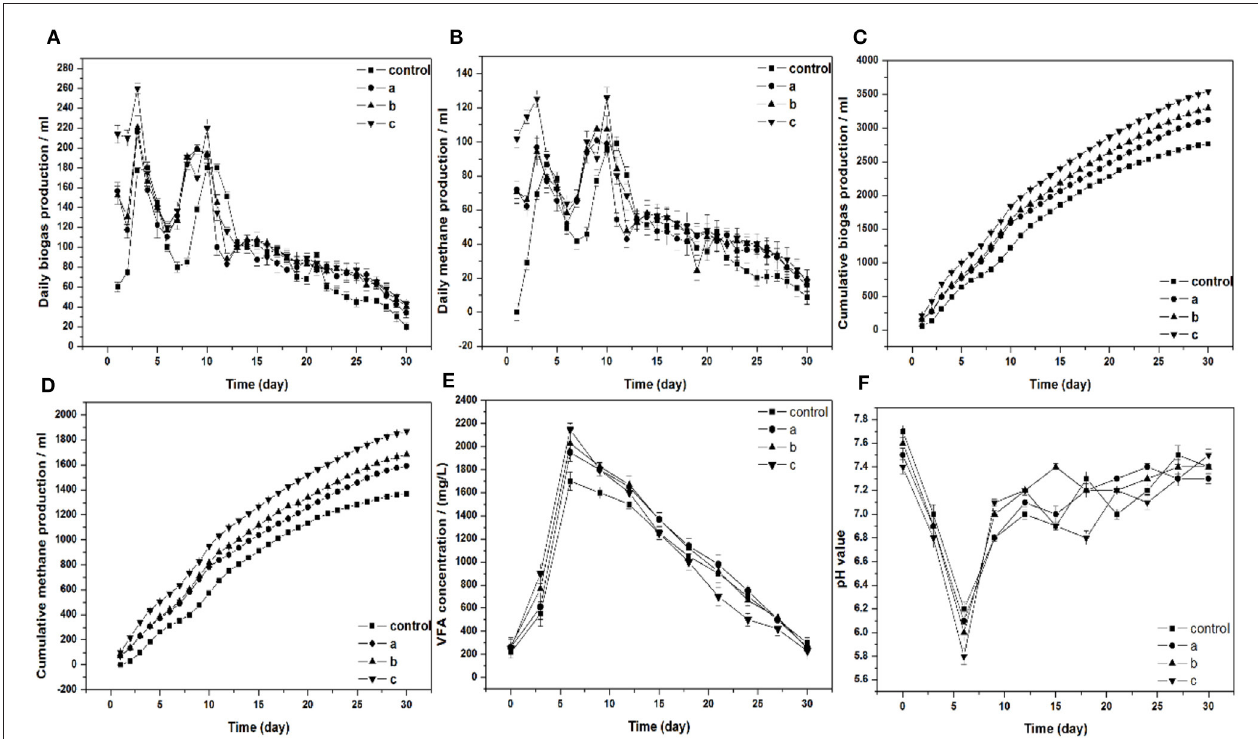
FIGURE 2 | (A) Daily biogas production, (B) daily and cumulative methane production, (C) cumulative biogas production, (D) cumulative methane production, (E) VFA concentration, (F) pH value, respectively, in batch fermentation from wheat straw affected by adding different ratios of Pg residues (a, b, and c: the ratios of Pg residues/wheat straw are 3, 5, and 10%,